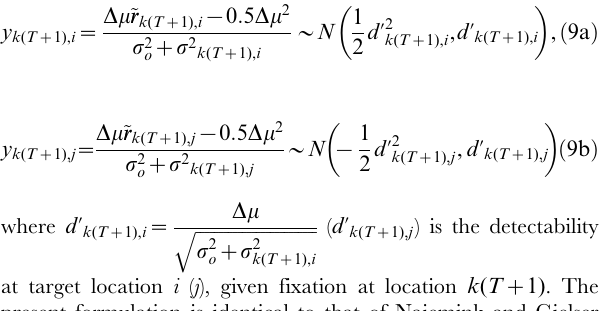
Video S1 Virtual evolution of linear neural mechanisms (templates) for perception (ventral stream) and saccadic action (dorsal stream) for search of an elongated Gaussian target. Video shows for each generation a perception and saccade template of a randomly sampled simulated individual. Legend below video indicates the generation number. Found at: doi:10.1371/journal.pcbi.1000930.s005 (7.83 MB GIF) Video S2 Virtual evolution of linear neural mechanisms (templates) for perception (ventral stream) and saccadic action (dorsal stream) for search of a cross pattern consisting of a positive and negative polarity elongated Gaussian. Video shows for each generation a perception and saccade template of a randomly sampled simulated individual. Legend below video indicates the generation number. Found at: doi:10.1371/journal.pcbi.1000930.s006 (8.65 MB